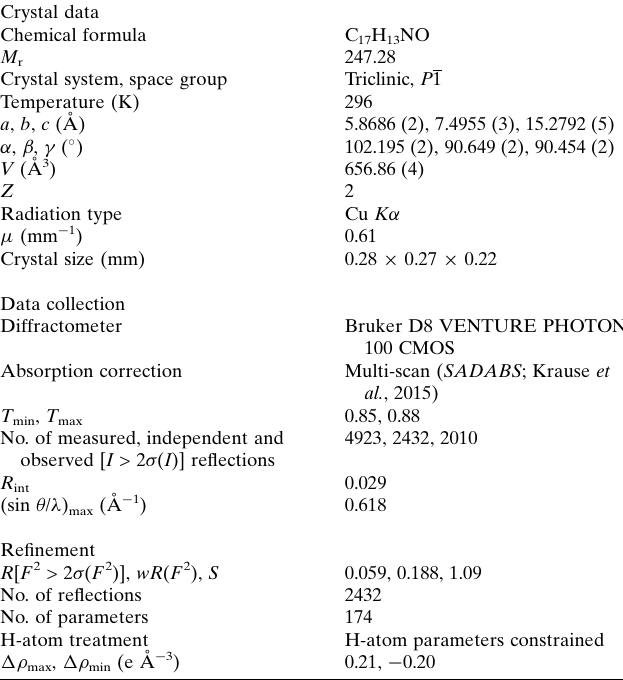
Table 1 Hydrogen-bond geometry (A˚ , (cid:2) ).